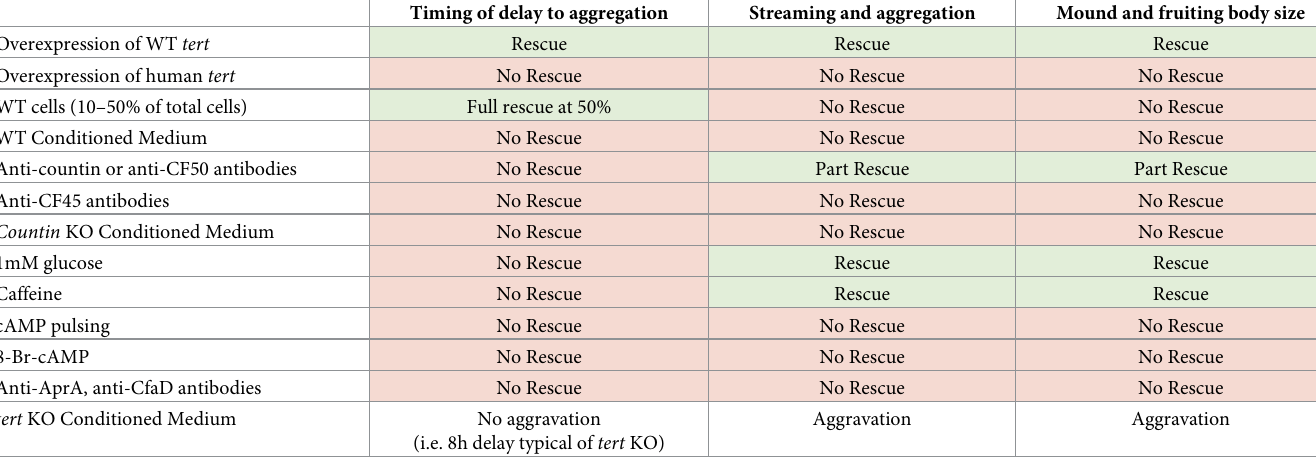
Table 2. Attempts to rescue normal phenotype (or aggravate the KO phenotype) in D . discoideum tert KO cells. Timing of delay to